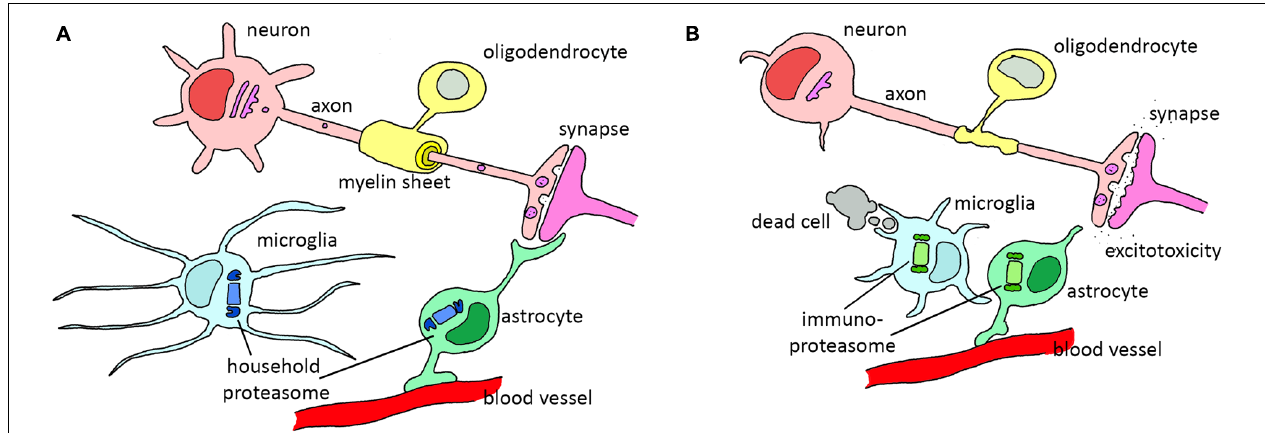
Astrocytes decrease glutamate uptake from the synapse, leading to excitotoxicity. Microglia become activated and phagocytize dead cells and start to secrete pro-inflammatory cytokines that activate astrocytes. Both reactive astrocytes and activated microglia upregulate immunoproteasome expression. In particular diseases, demyelination of the axons is observed due to oligodendrocyte